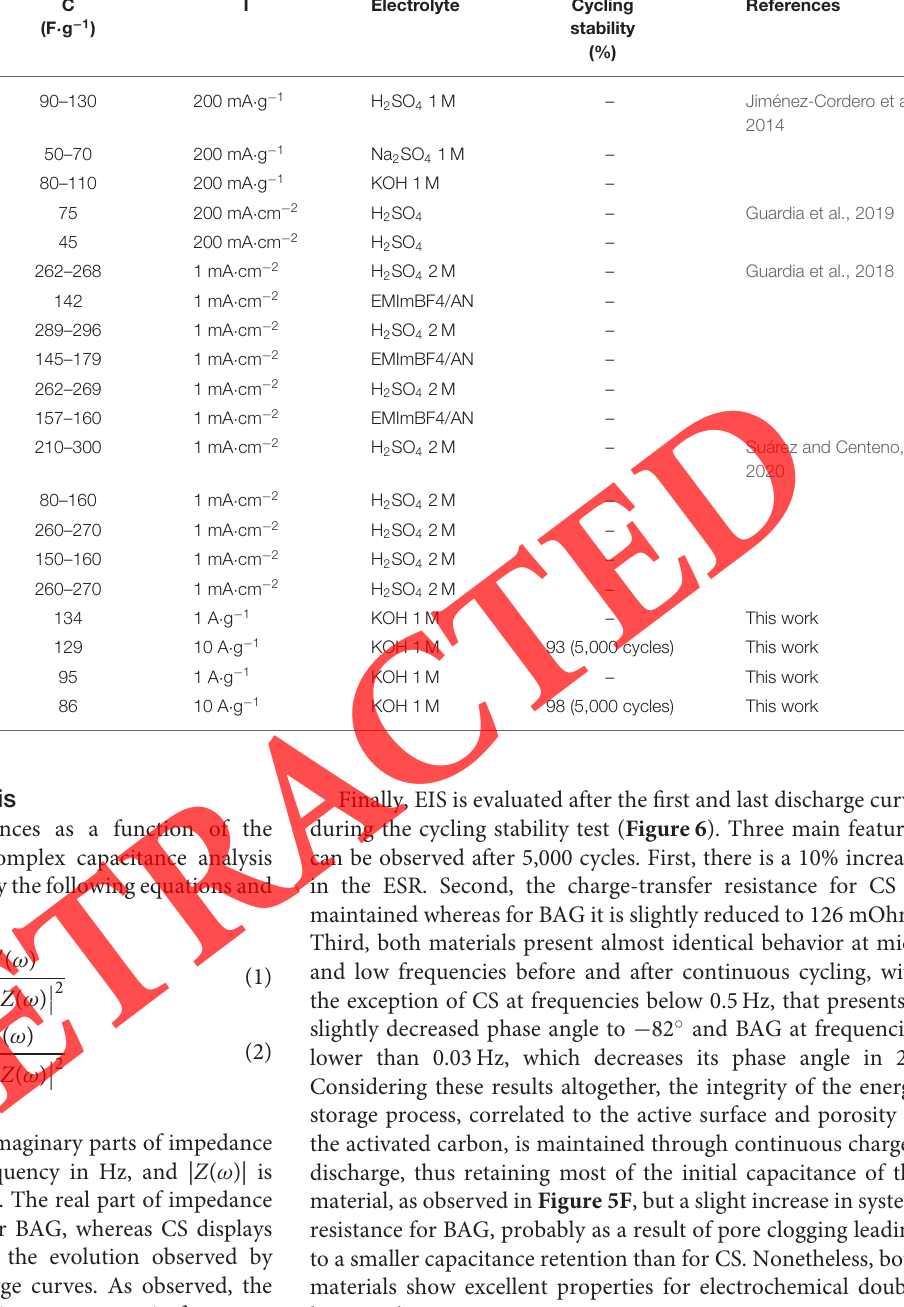
TABLE 2 | Comparison of obtained electrochemical results with previous work on activated carbons from winemaking waste.